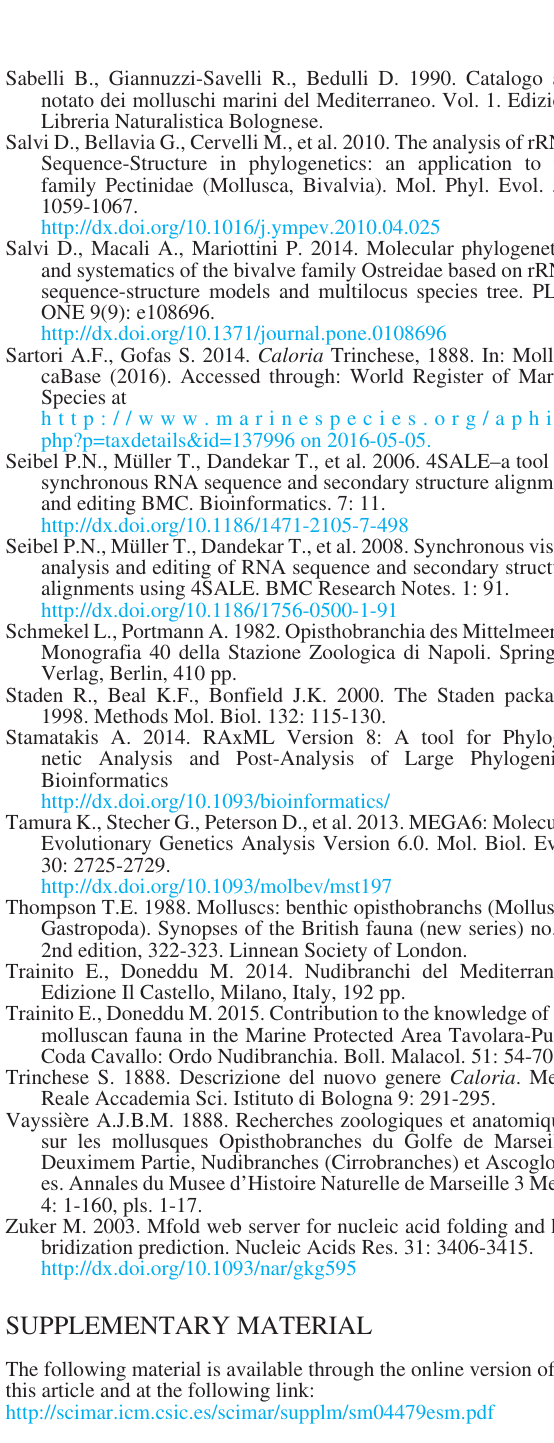
Fig. S1. – Phylogenetic relationships among facelinid species based on the Bayesian analysis of partitioned (16S+COI) mitochon- drial dataset. Numbers at nodes are Bayesian posterior prob- ability and ML bootstrap support, respectively. Fig. S2. – Phylogenetic relationships among facelinid species based on the Bayesian analysis of single nuclear gene dataset (H3). Numbers at nodes are Bayesian posterior probability and ML bootstrap support,